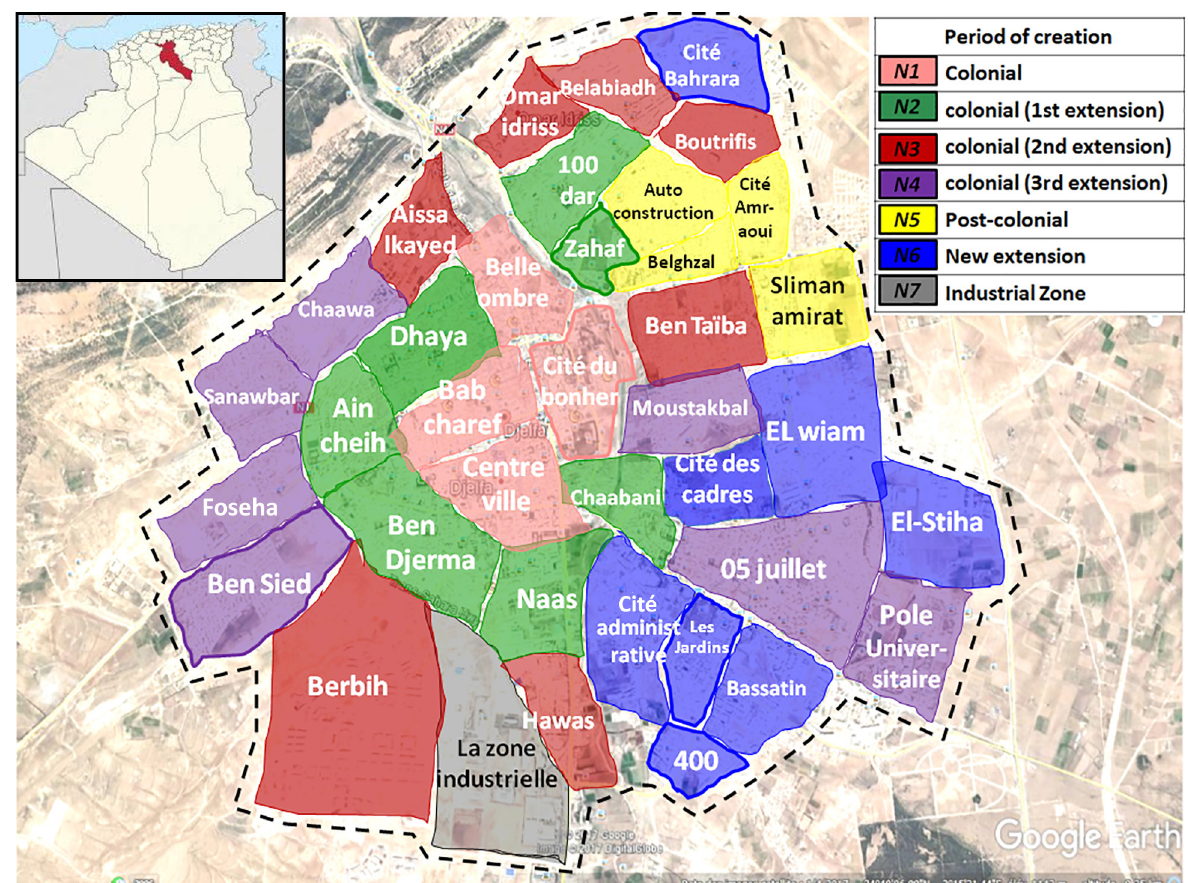
Fig. 1. Study area and the neighbourhoods of the city according to their period of creation. Source: own composition based on Bouzidi et Boukhari